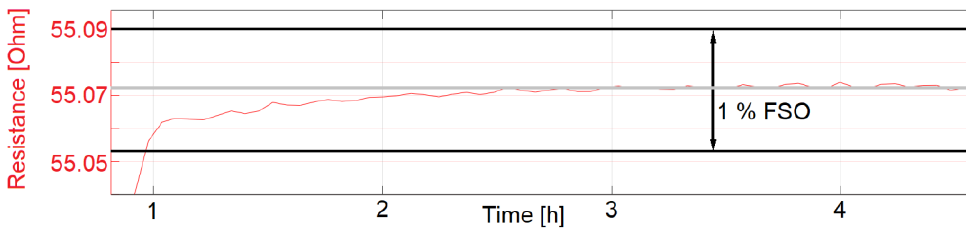
Figure 15. LCP 1 (with coating) start-up drift, zoomed to 1% FSO.